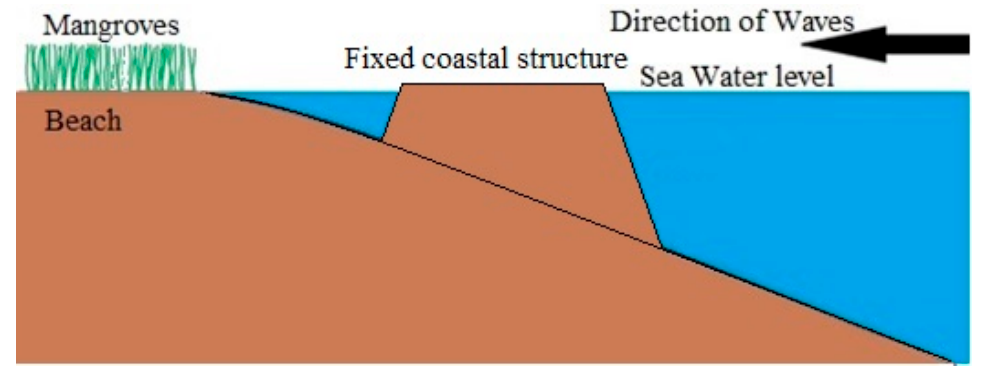
Figure 1. Integration of mangroves with fixed coastal protection structure (adapted from Yuanita et al.)